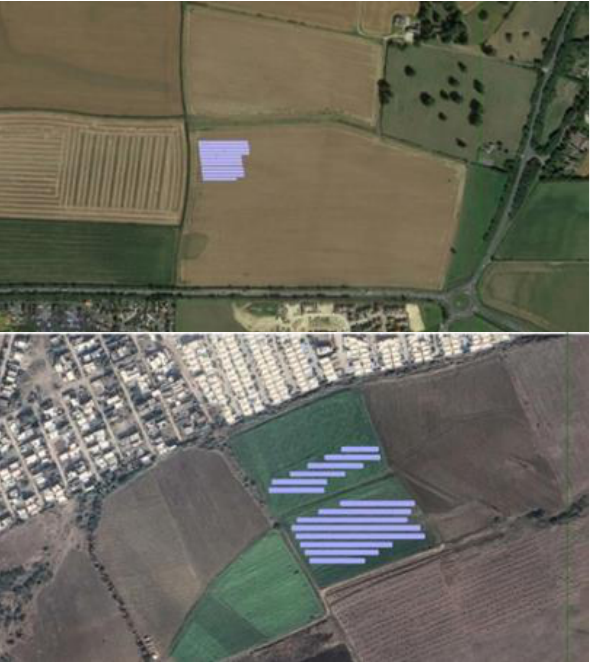
Figure 3. Image for Lincoln ( top ) and Bhavnagar solar farms ( bottom ).